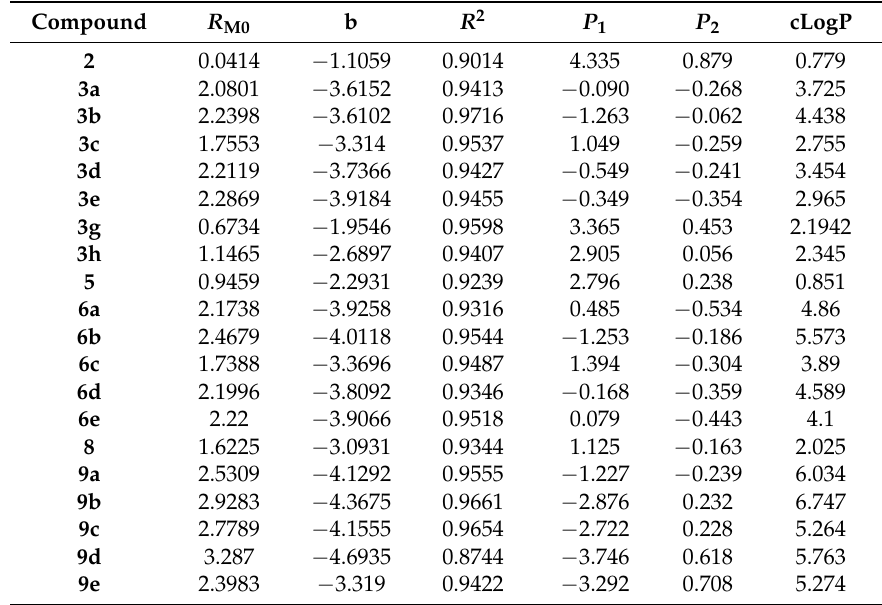
Table 5. Regression data, scores of the two first principal components and cLogP values for the studied